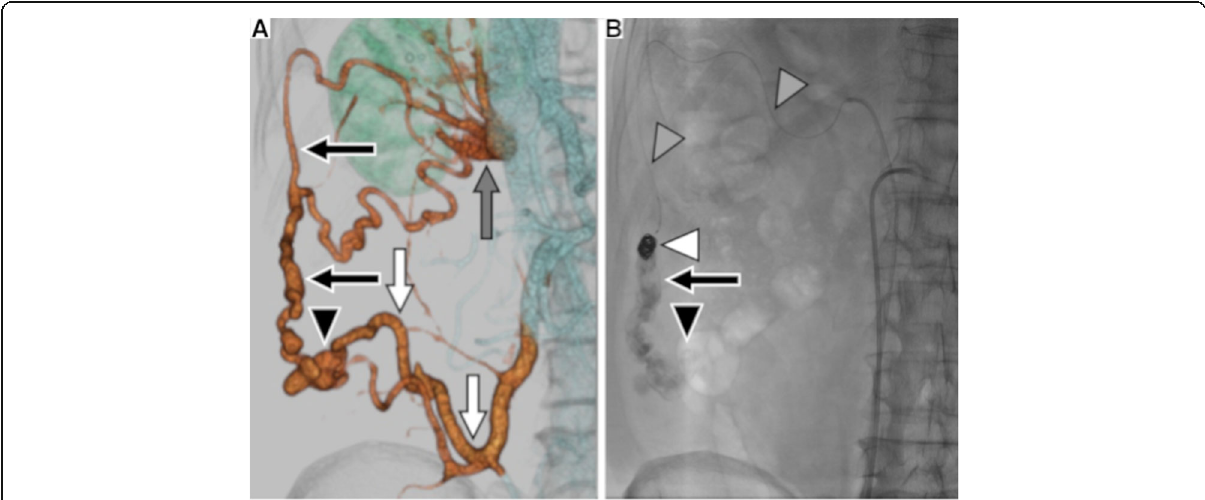
Fig. 2 Overviews of anatomy and treatment. a Three-dimensional volume rendering image (VR image) reconstructed from contrast medium- enhanced CT. The image shows the ascending colonic varix (black arrowhead), the main draining vein (black arrows), and the ileocolic vein (white arrows) as a feeder vein. The gray arrow shows the right renal vein. b Overview X-ray image. After injection of the sclerosing agent, microcoils (white arrowhead) are inserted via the microballoon catheter (gray arrowheads). When the balloon is deflated, contrast medium is retained in the colonic varix (black arrowhead) and the draining vein (black arrow)